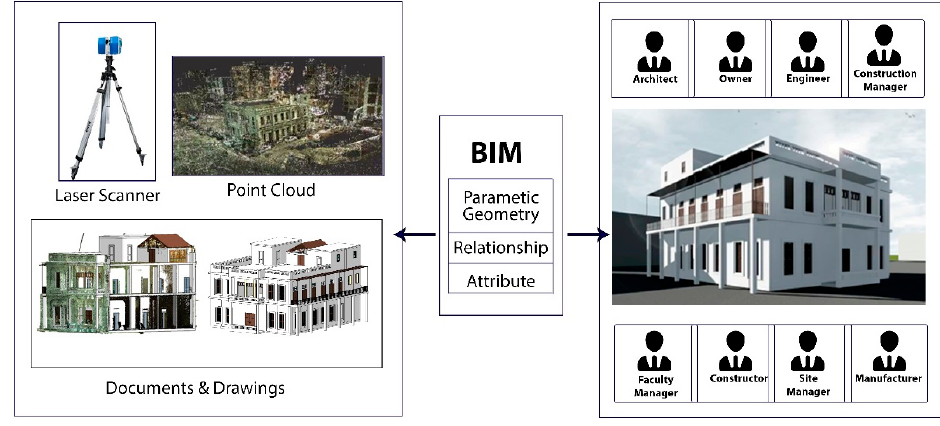
Figure 3. Working parameters of HBIM.